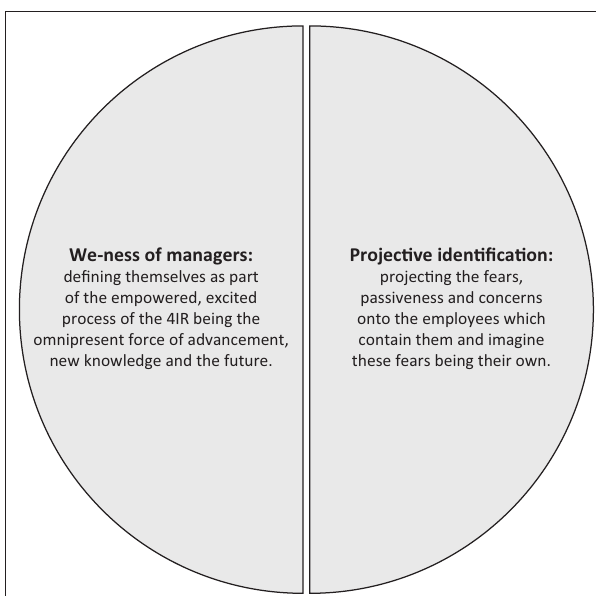
FIGURE 5: We-ness and projective identification.